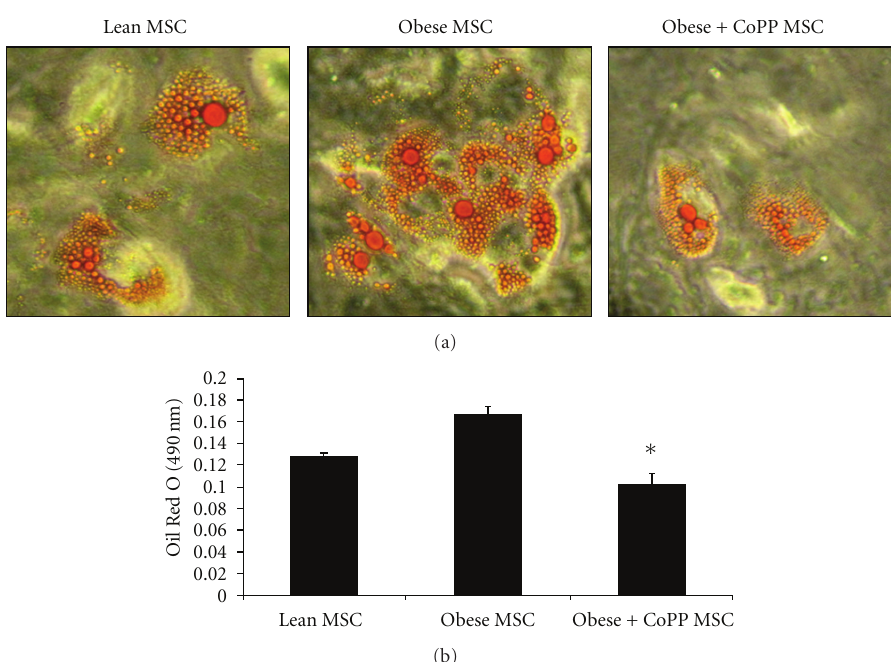
Figure 4: E ff ect of CoPP on MSC-derived adipogenesis. Adipogenesis was measured as the relative absorbance of Oil Red O at day 10. (a) Representative pictures demonstrating an increase in lipid droplets in the MSC of obese mice compared to lean mice and obese mice treated with CoPP. (b) Quantitative analysis of adipogenesis showing a significant increase in Oil Red O staining in the obese MSC-derived adipocytes. Data are expressed as mean ± SE ( ∗ P < 0 . 01 obese versus CoPP). Note: unpublished